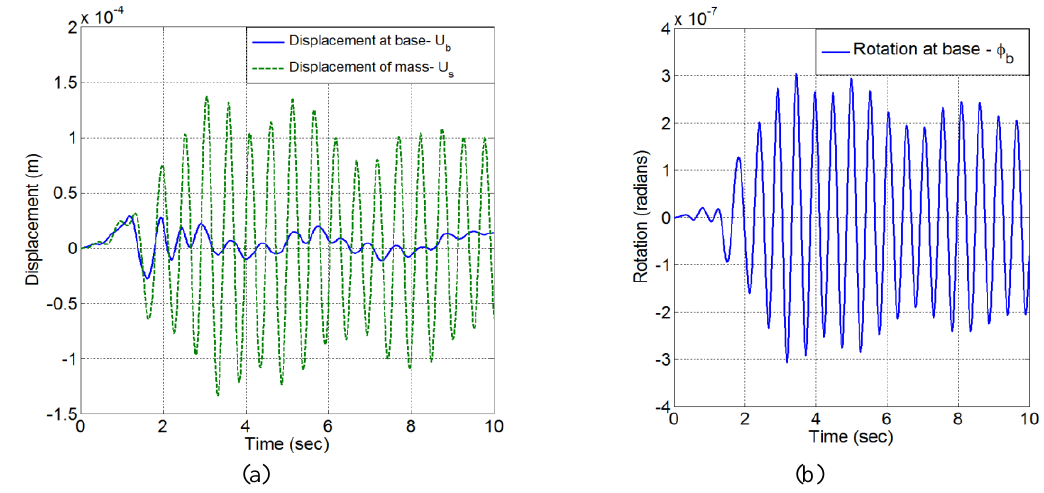
Figure 9. (a) and (b) Displacement time history of the 3DOF SSI system under EQ